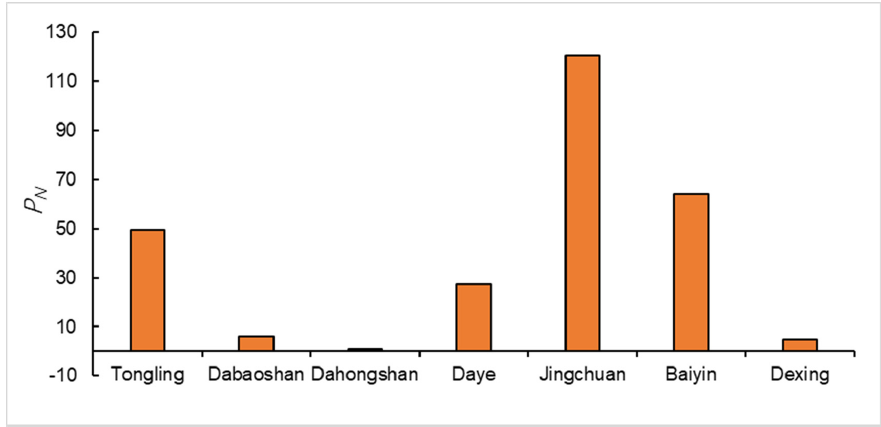
Figure 3. Nemerow index of sediments in rivers surrounding typical copper mines.